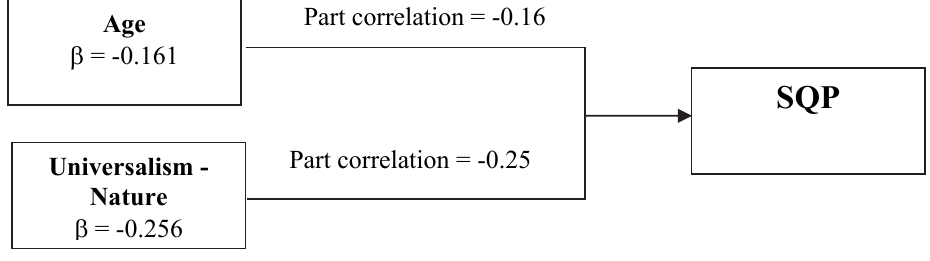
Fig. 3. Summarises the Multivariate Results between Independent Variables and